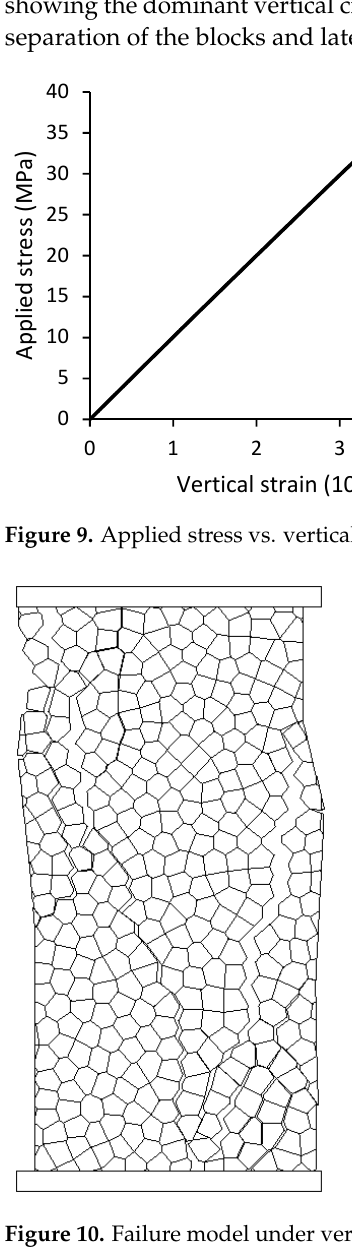
Figure 10. Failure model under vertical compression.